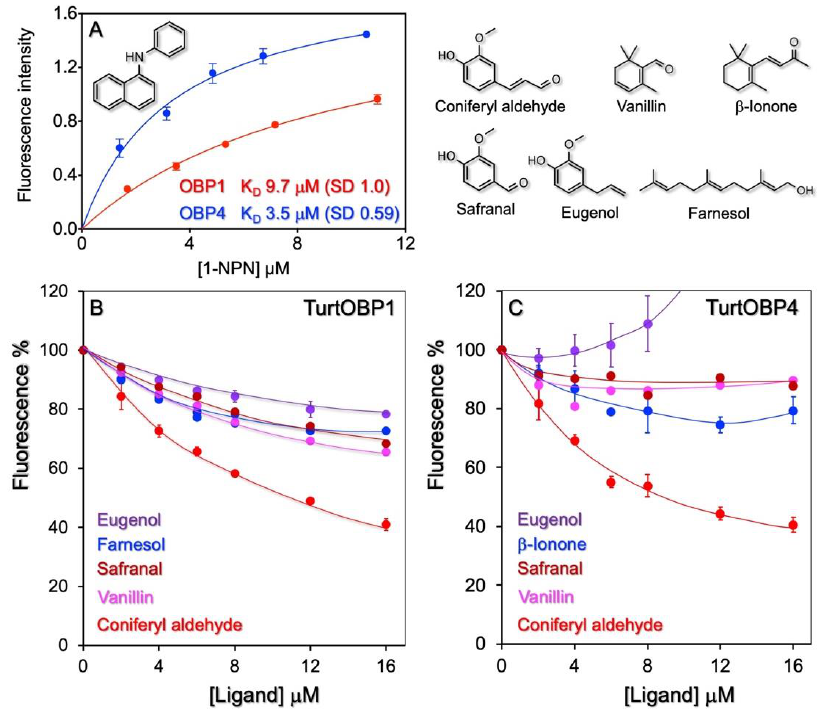
Figure 4. Ligand-binding experiments. ( A ) Only TurtOBP1 and TurtOBP4 bind the fluorescence probe N-phenyl-1-naphthylamine (1-NPN) with moderate dissociation constants, while TurtOBP2 and TurtOBP3 did not produce any change in the spectrum of 1-NPN. ( B , C ) Examples of competitive binding experiments performed with TurtOBP1 and TurtOBP4. Tested chemicals are reported in Supplementary Table S3. Only coniferyl aldehyde showed a moderate affinity. For TurtOBP2 and TurtOBP3, we could only monitor quenching of the intrinsic fluorescence of tryptophan (Supplementary Figure S3). The structures of the used ligands are reported in the upper right part of the